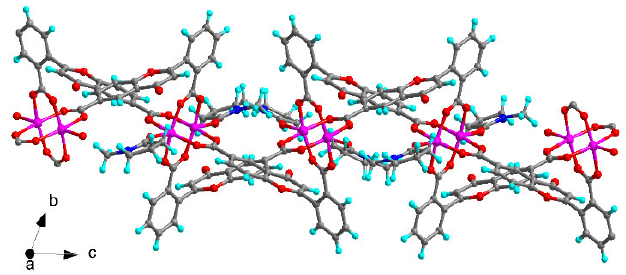
Figure 2. The 2D structure of LDU-1 view along a direction. Table 1. Crystal data for LDU ‐ 1.